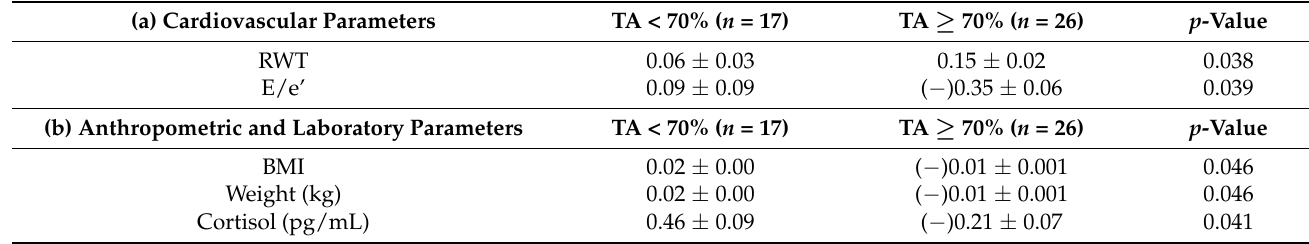
Table 3. Analysis of cardiometabolic parameters, by TA.